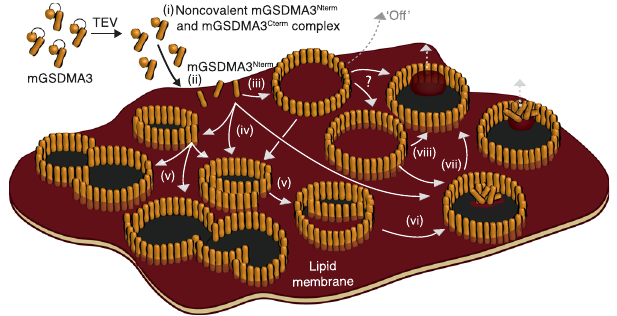
Fig. 8 Pathways of mGSDMA3 Nterm membrane pore